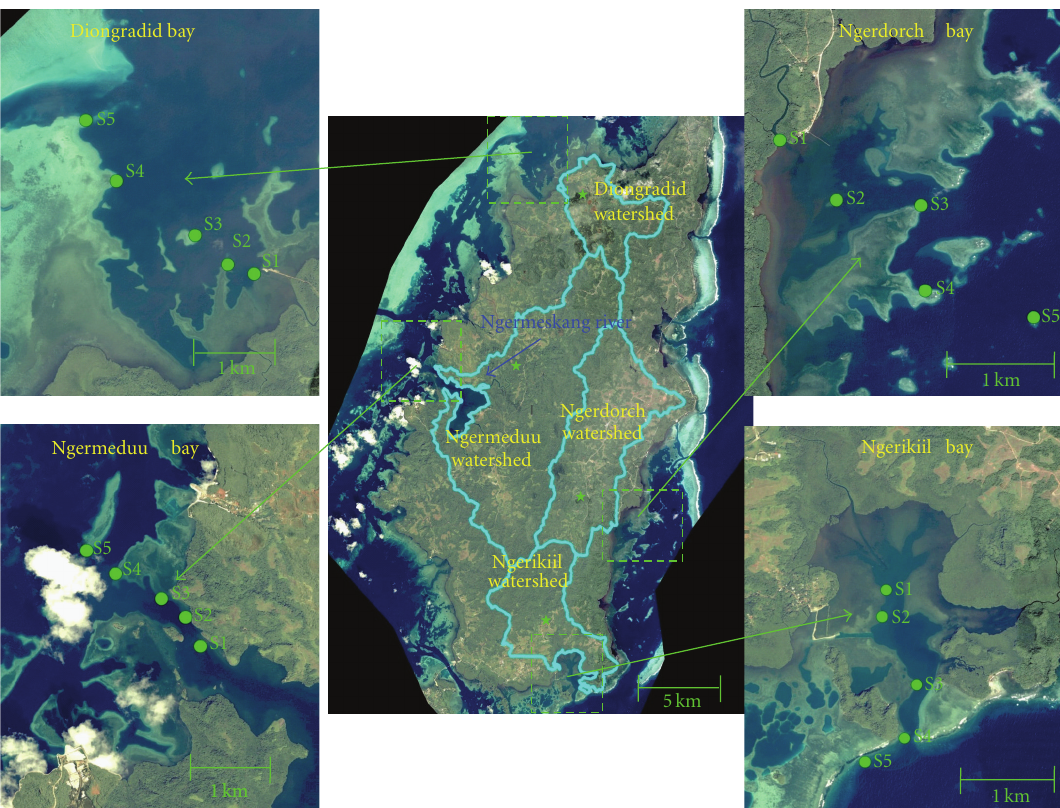
Figure 2: Aerial photograph of Babeldaob showing the four watersheds and a close-up of their adjacent bays with stations (S) marked. Stars indicate locations of level loggers along the river in each